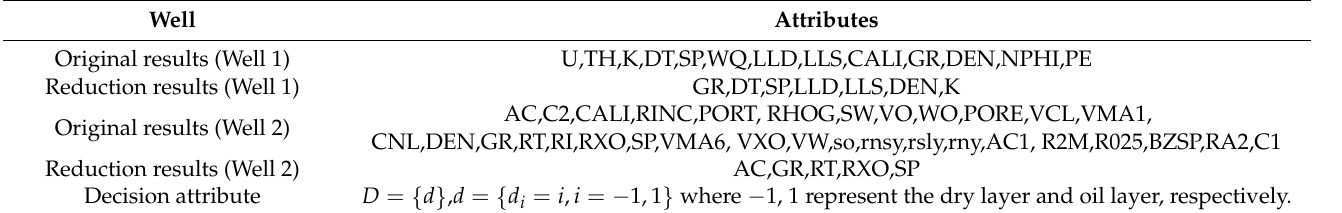
Table 5. Results of attribute reduction.